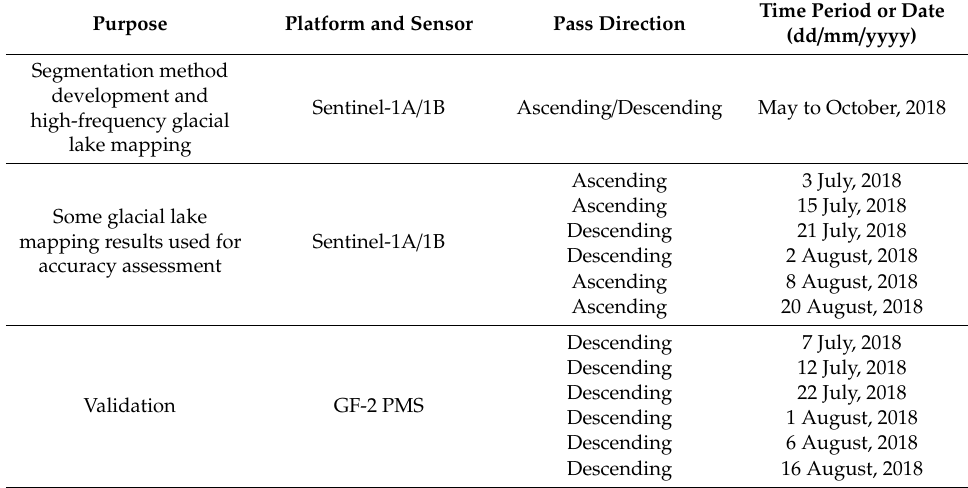
Table1. ListofSentinel-1A / 1Bimagesforthemethoddevelopmentandglaciallakemappingexperiment, and corresponding GF-2 PMS images used for